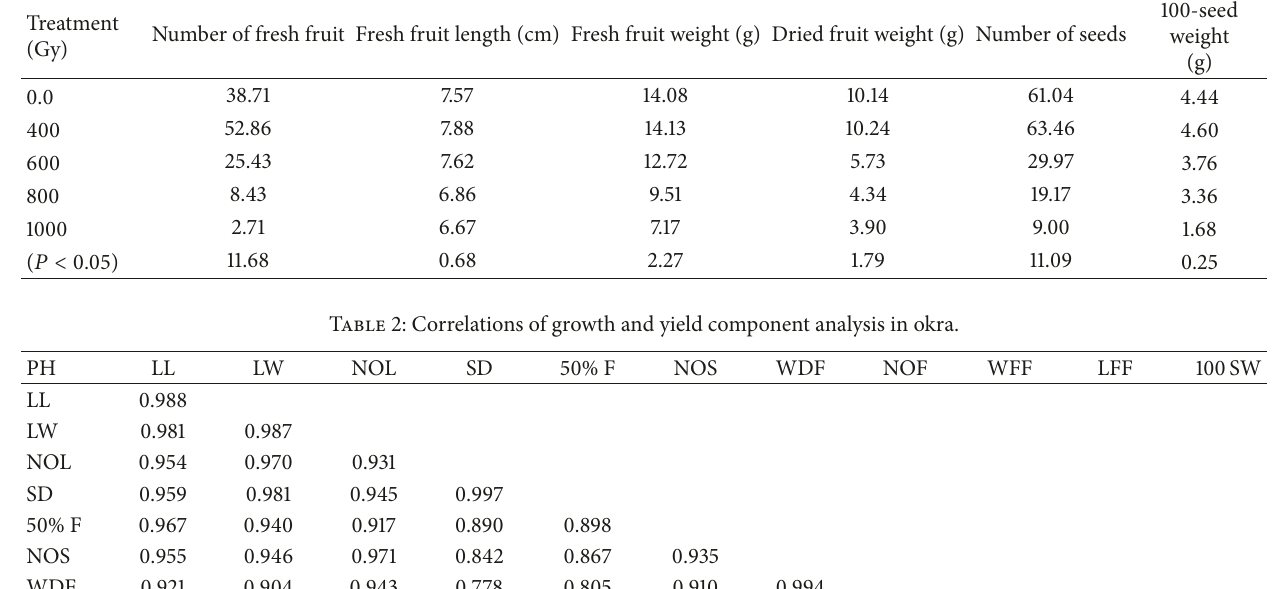
Table 1: The effects of doses of gamma irradiation on fruit and seed yield in okra. Treatment